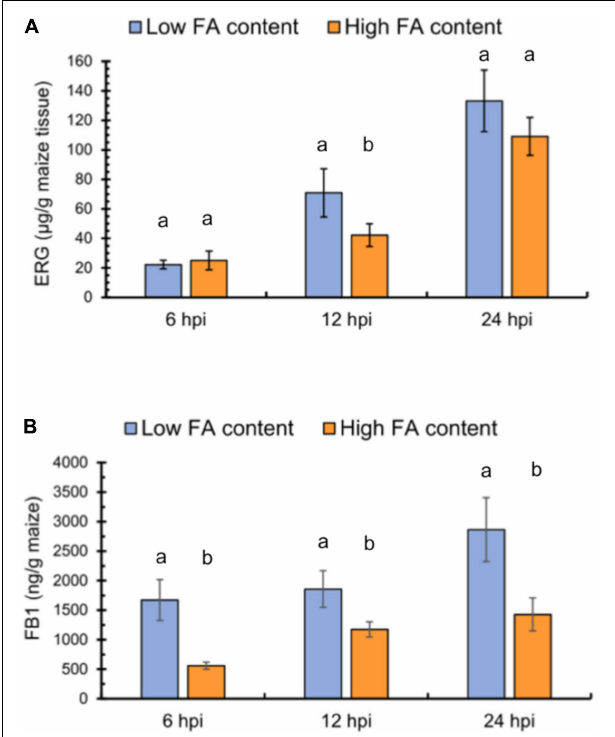
FIGURE 3 | F. verticillioides interaction with maize seeds containing low or high ferulic acid levels. (A) Fungal colonization, as determined by ergosterol (ERG) levels in maize seeds with low (blue) or high (orange) FA contents at 6, 12, and 24 h post-inoculation (hpi). (B) FB1 production in maize seeds with low or high FA contents at 6, 12, and 24 h post-inoculation (hpi). Different lowercase letters indicate significant differences, as analyzed by Student’s t -test ( n = 3; p <